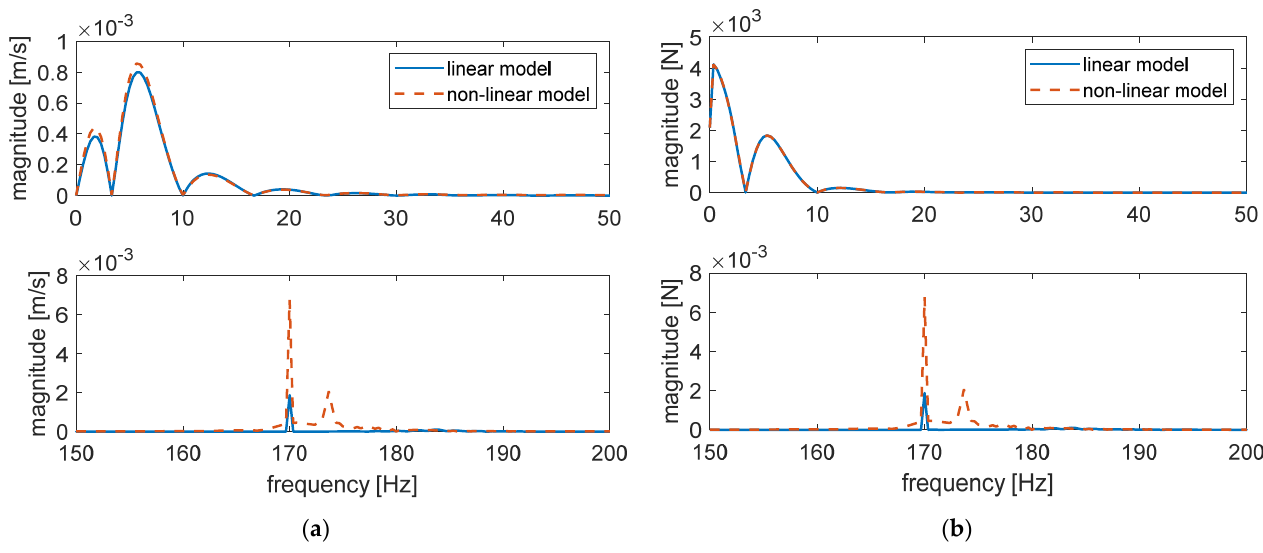
Figure 14. Spectra of the simulated vertical velocity of the rail obtained by the non-linear and linear models of unit length of the reference ERS subjected to a load simulating a train passage (ETR 500 coach at 72 km/h) and a dynamic force caused by a rail roughness with a wavelength of 120 mm (170 Hz) with an amplitude of 20 N: ( a ) spectra of the rail velocity; ( b ) spectra of the transmitted force. All spectra are calculated with a time window of 3 s.